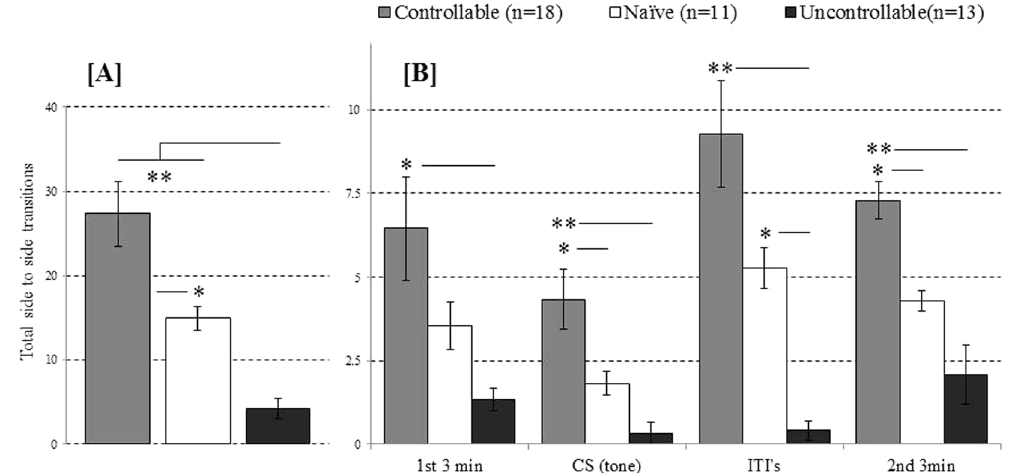
Figure 2. ( A , B ) Performances in the test after exposure to training in the ‘TWSA’ task: ( A ) controllable rats exhibited significantly more side to side transitions during the test, compared to naïve and uncontrollable rats. Likewise, uncontrollable rats exhibited significantly less transitions compared to naïve rats; ( B ) Significant differences in side to side transitions between controllable and uncontrollable rats were evident in each stage within the test (i.e. 1 st 3 min exploration, exposure to the CS, during ITI’s and during the 2 nd 3 min exploration; * > 0.05, ** > 0.001).